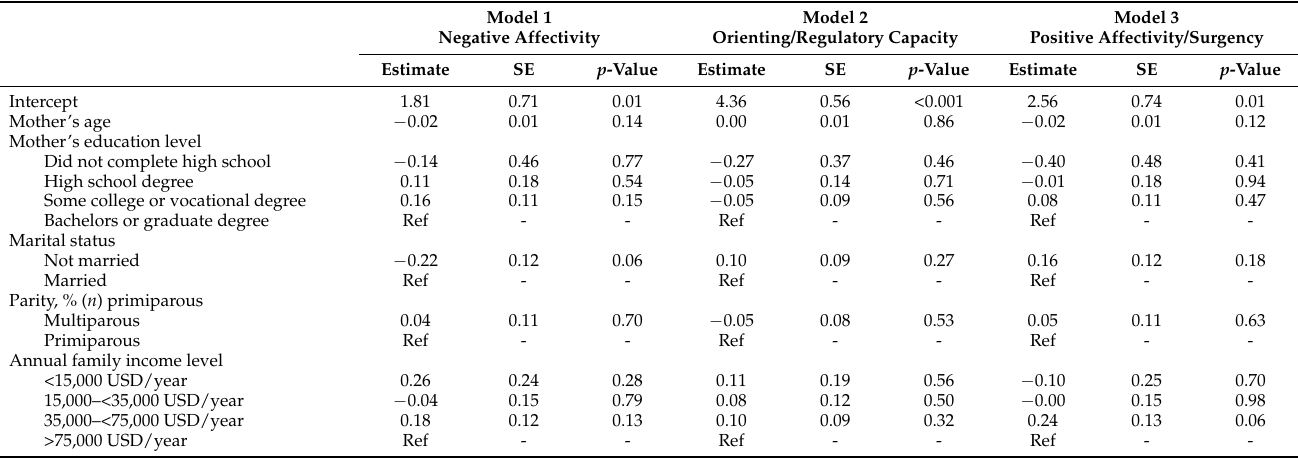
Table 3. Infant age moderates associations between maternal technology use and dimensions of infant